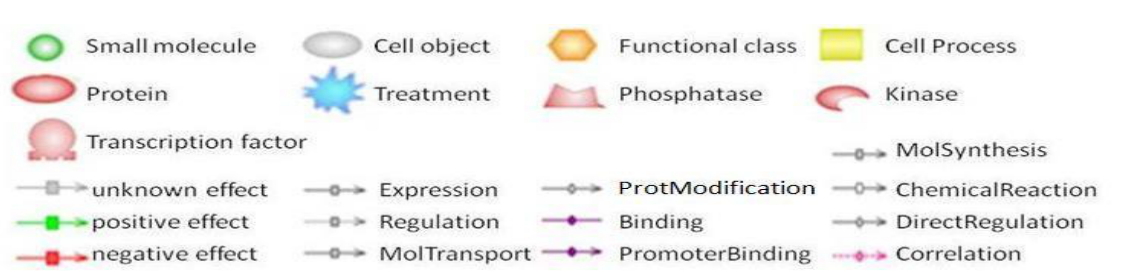
Legend for Figure 2 to Figure